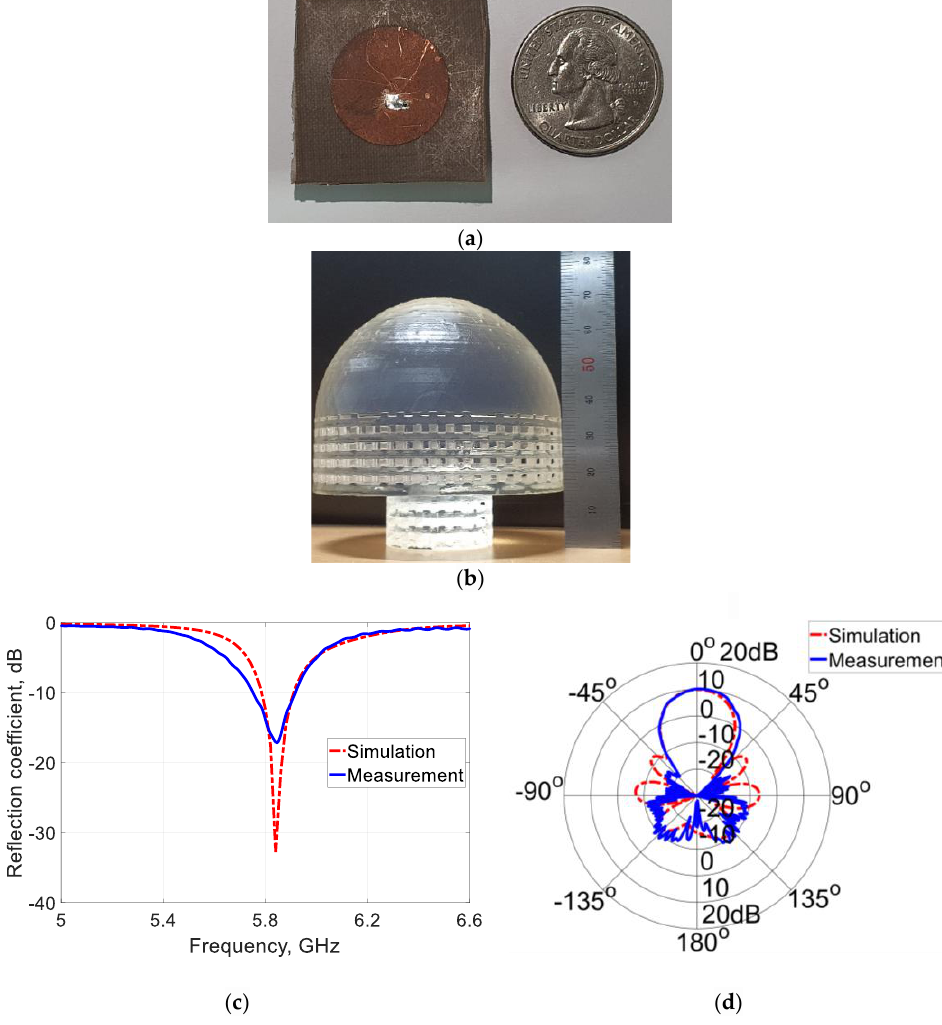
Figure 9. Fabrication of the proposed lens antenna. ( a ) Microstrip patch antenna. ( b ) Proposed dielectric lens antenna. ( c ) Reflection coefficient. ( d ) 𝜃 -sweep radiation pattern ( 𝜙 = 0° ).